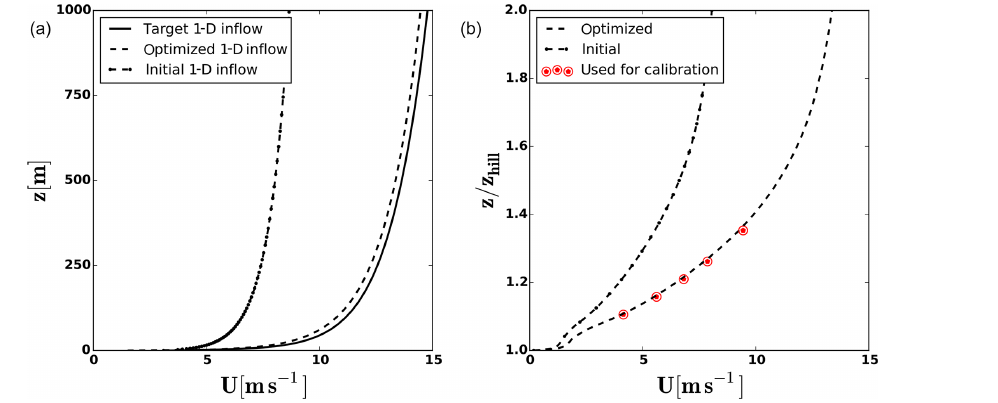
Figure 11. The target, initial and optimized 1-D inflow velocity (a) . The velocity profile over the hill from which the pseudo-measurements are chosen (b)